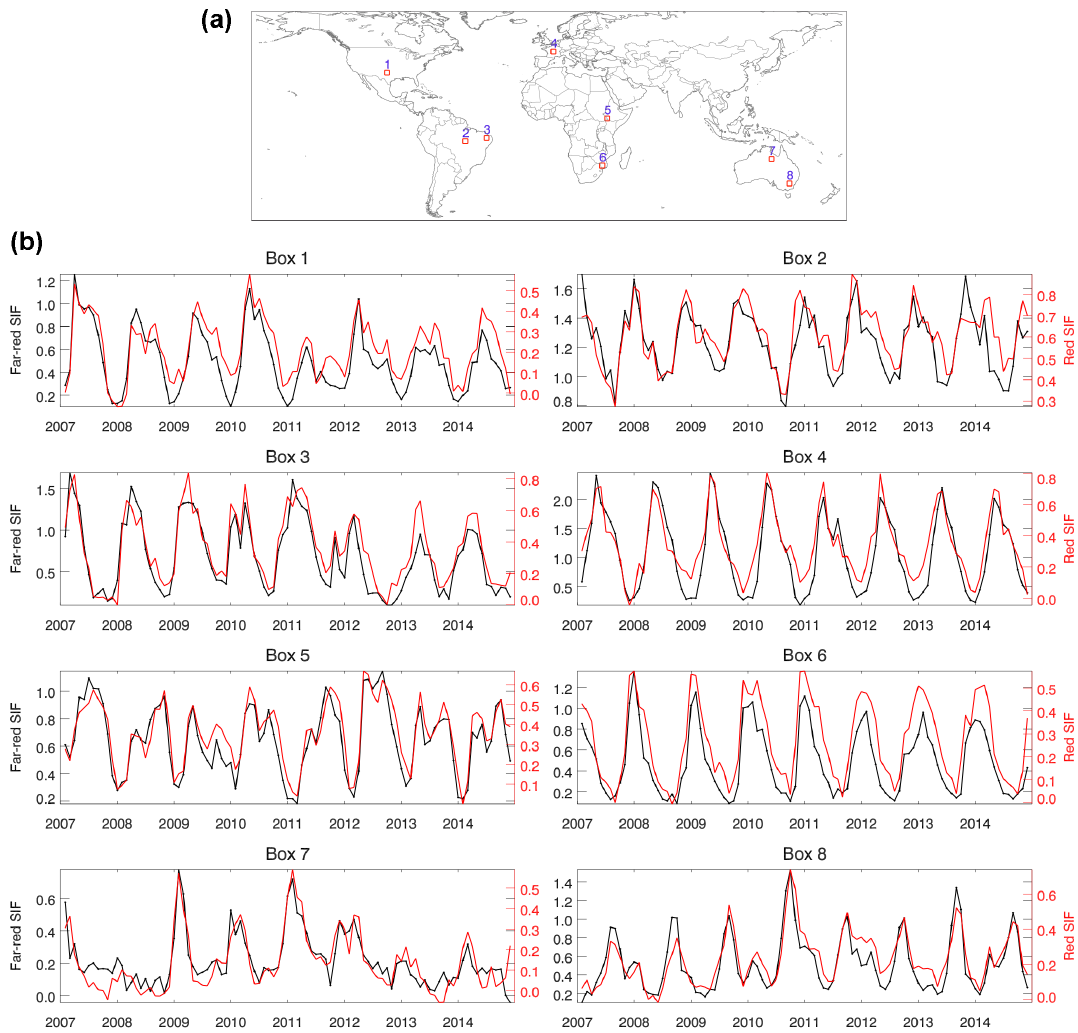
Figure 11. (a) Map showing boxes where SIF time series will be examined. (b) Time series of monthly red (red, right axes) and far-red SIF (black, left axes) in mWm 2 nm − 1 sr − 1 from GOME-2 for eight boxes shown in (a)